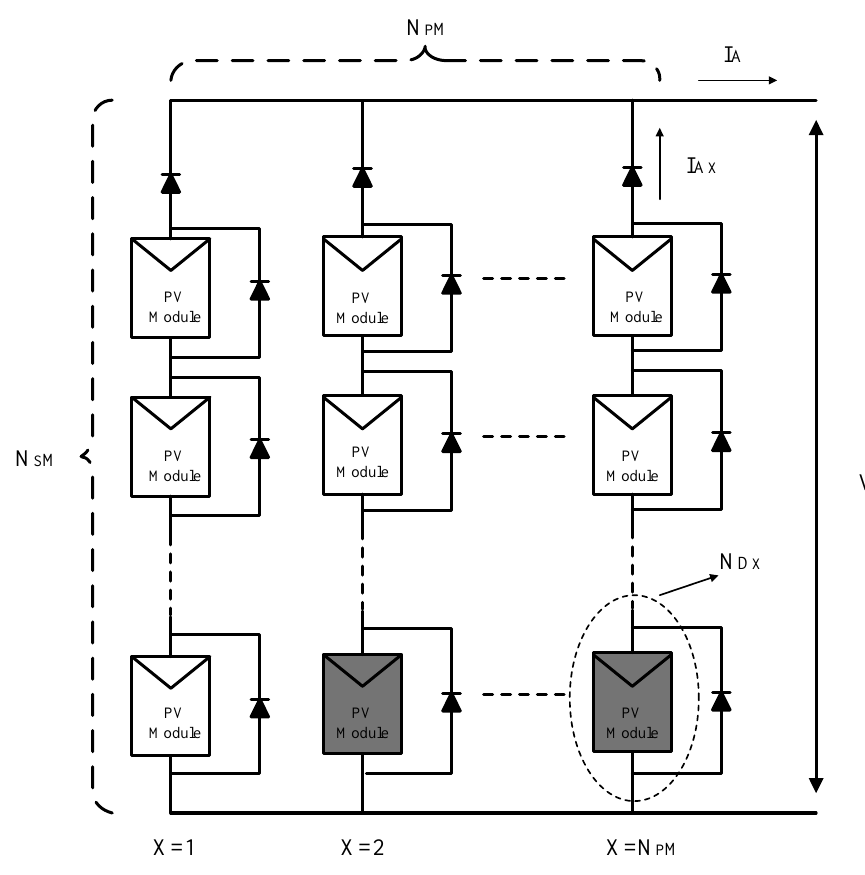
Figure 2. Series-parallel (SP) configuration of Photovoltaic (PV)